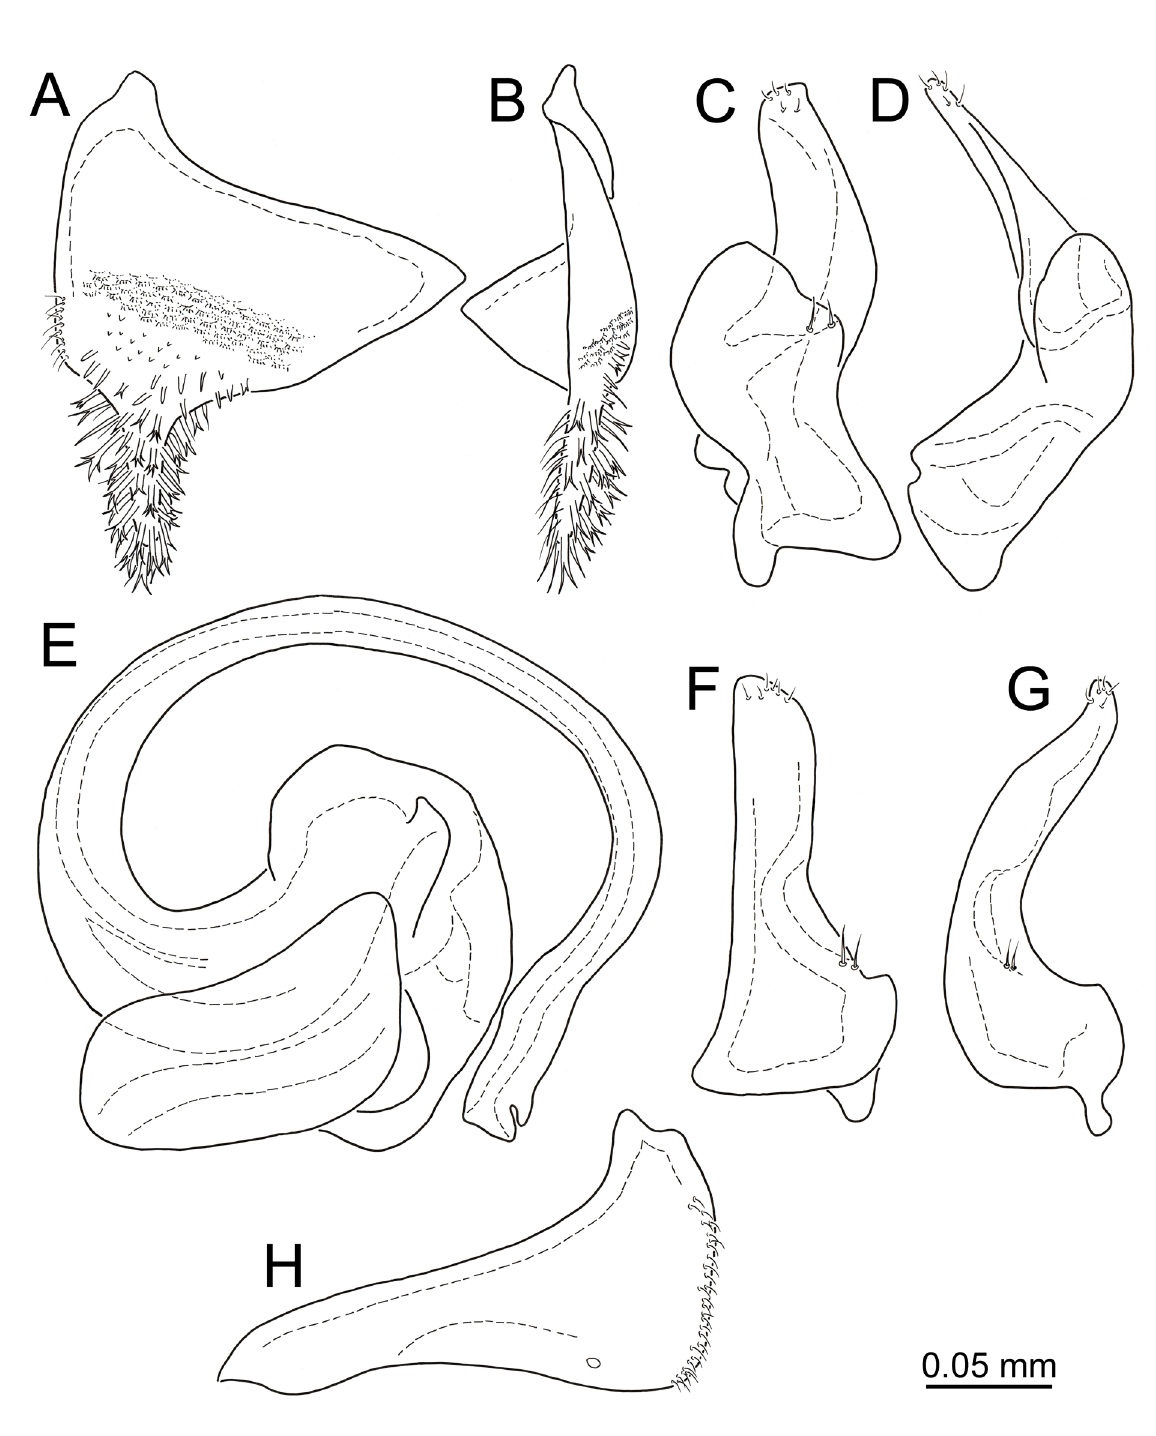
Fig. 8. Kokeshia caii sp. nov., segment VIII and genitalia, paratype, ♂ (SYSBM). A‒B . left hemitergite VIII. A . Dorsal view. B . Left lateral view. C‒D . Left paramere, two different aspects. E . Phallus. F‒G . Right paramere, two different aspects. H . Right hemitergite VIII, dorsal